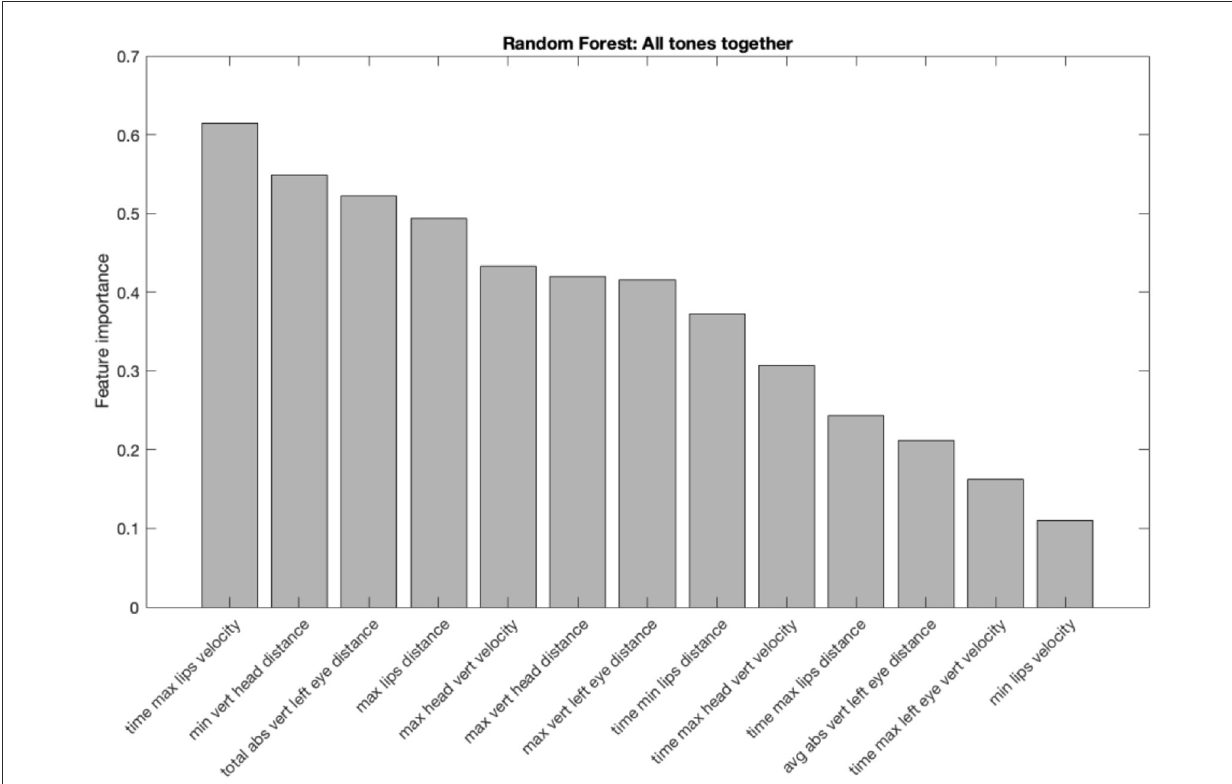
FIGURE2 Important features identified by the random forest analysis in differentiating the two speech styles (clear and plain). The y-axis shows the feature importance measured by the random forest. The feature importance measures the increase in classification error if the values of the feature are permuted. The greater the error the higher the importance of the feature